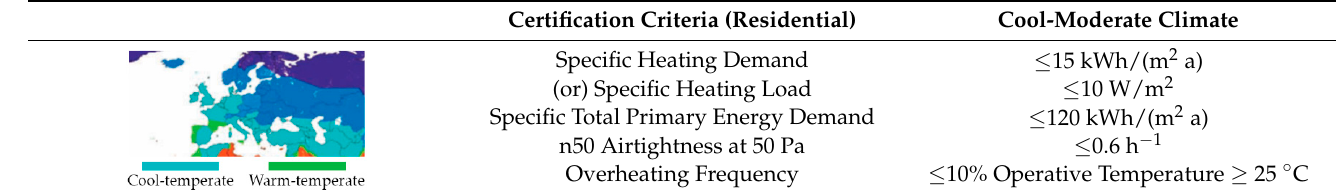
Table 1. Summary of the main Passivhaus certification criteria for cool-moderate climates (e.g., London, Paris, Vienna, Rome, Budapest, Istanbul, Beijing, Seoul, Tokyo, Tehran). Adapted from [52]. Certification Criteria